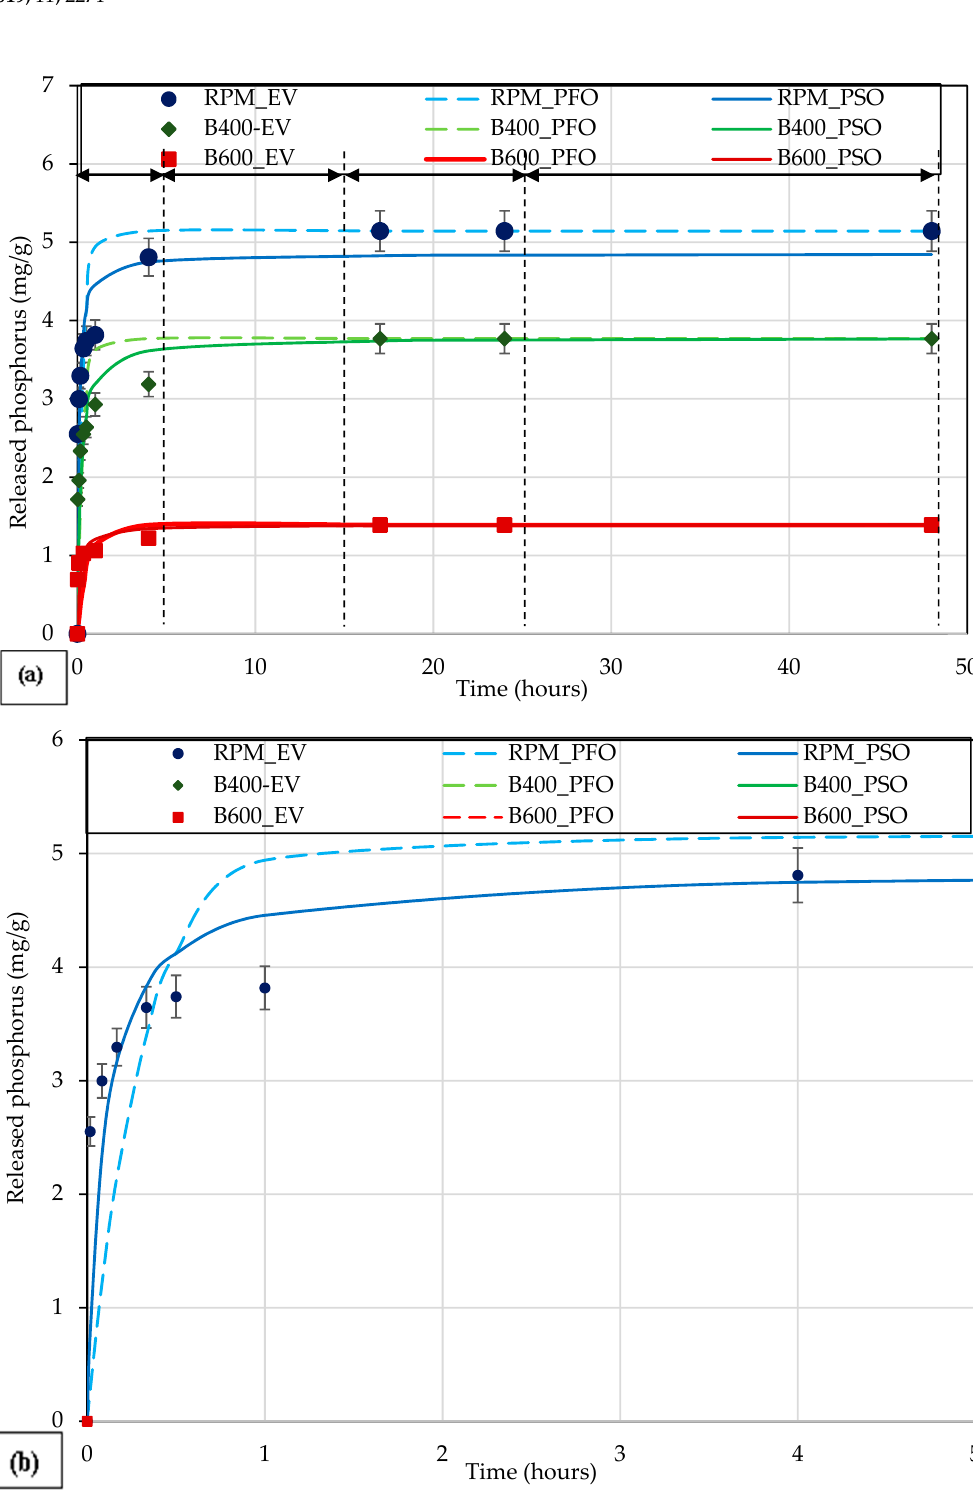
Figure 2. Comparison between the experimental quantities and theoretical ones of phosphorus released by raw poultry manure (RPM) and its derived biochars (EV: Experimental values; PFO: pseudo-first order; PSO: pseudo-second order) for 48 h ( a ) and zoom for 5 h ( b ).